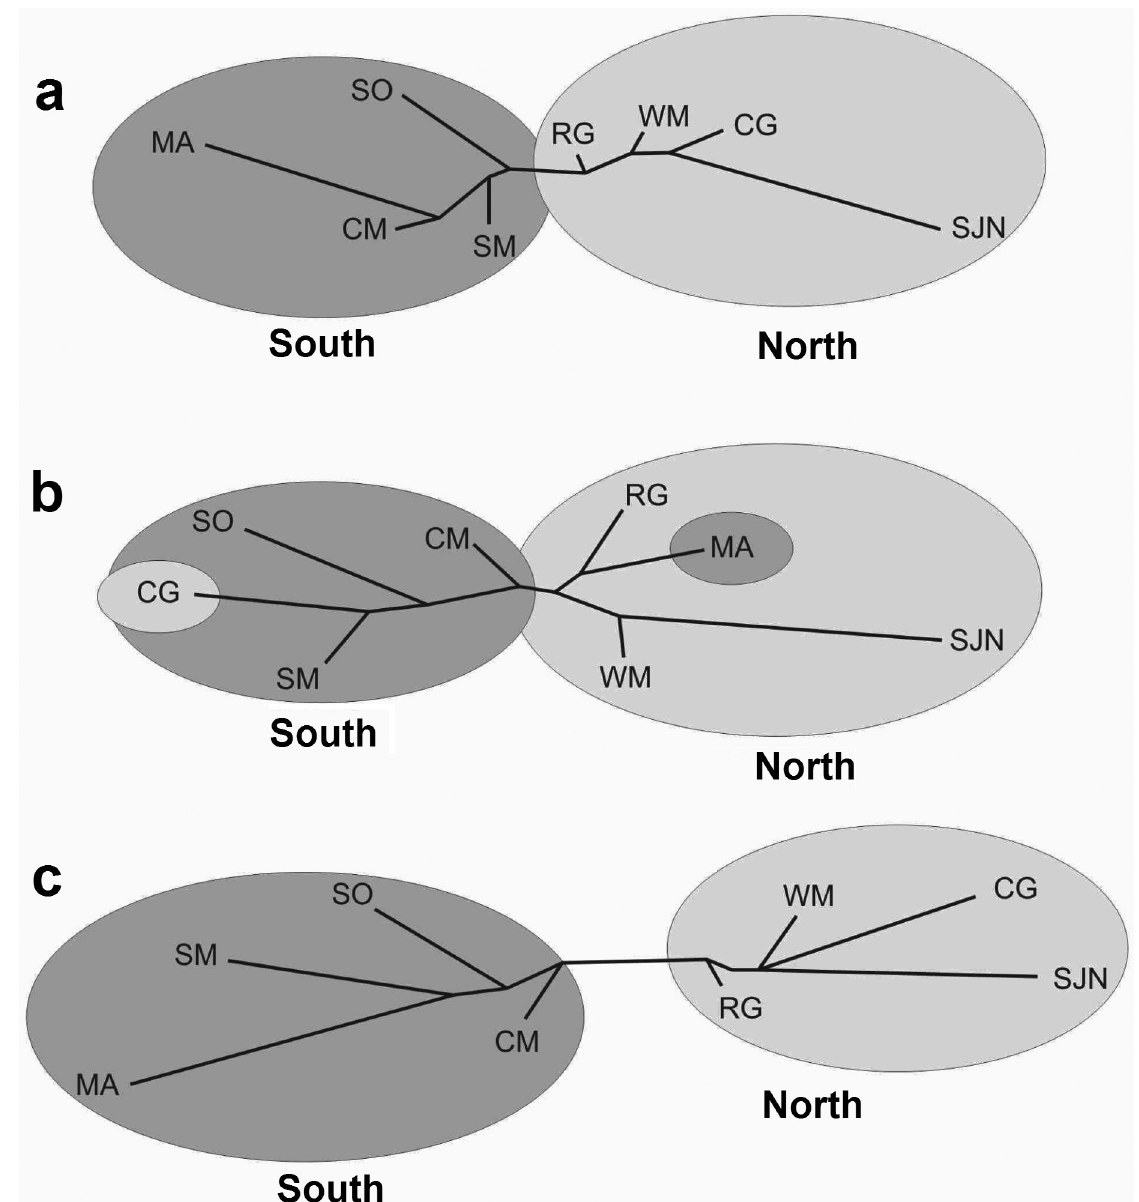
Figure 4 - Neighbor-joining phenograms generated from Mahalanobis distances for dorsal (a) , ventral (b) and lateral (c) views of the skull of Scapteromys tumidus . Acronyms correspond to geographic